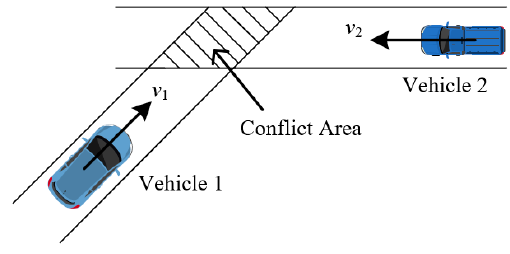
Figure 9. A schematic diagram of a conflict area